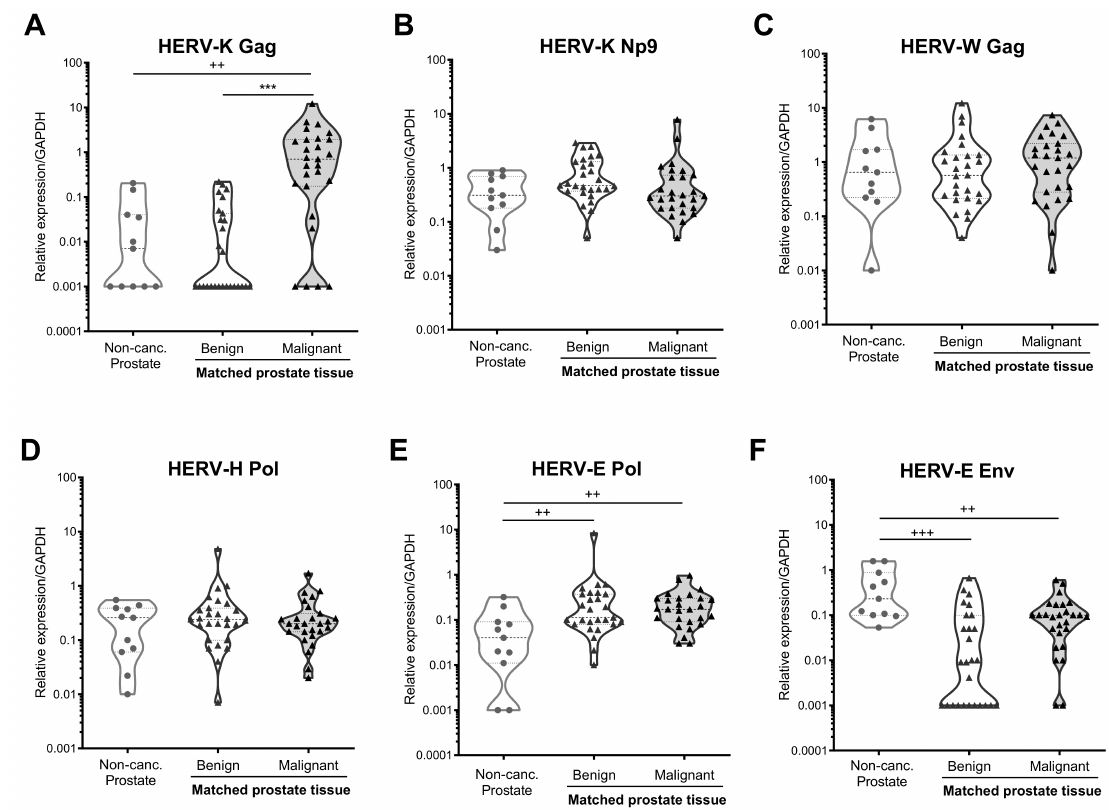
Figure 2. HERV transcript expression in prostate biopsy samples from males with and without prostate cancer. Expression of HERV-K Gag ( A ), HERV-K Np9 ( B ), HERV-W Gag ( C ), HERV-H Pol ( D ), HERV-E Pol ( E ) and HERV-E Env ( F ) transcripts were detected in RNA extracted from punch biopsy prostate samples from men without prostate cancer (Non-Canc. Prostate, n = 11), or from matched benign and malignant regions of the prostate from individuals with prostate cancer ( n = 27) by qRT-PCR. Graphs show truncated violin plots of the average gene expression standardised to copies of GAPDH from n = 3 replicates per sample. Samples with undetectable levels of HERV transcript are shown with a value of 0.001 for the purposes of visualisation in the graphs, and the actual value of 0 was used for statistical analyses. ++, and +++ indicate p < 0.01 and 0.001 respectively, as compared to non-cancerous prostate tissue, determined by Mann–Whitney U-test. *** indicates p < 0.001 for comparison of matched benign and malignant tissue, as determined by Wilcoxon matched-pairs signed-rank test. Non-parametric tests were used due to non-normal distribution of the